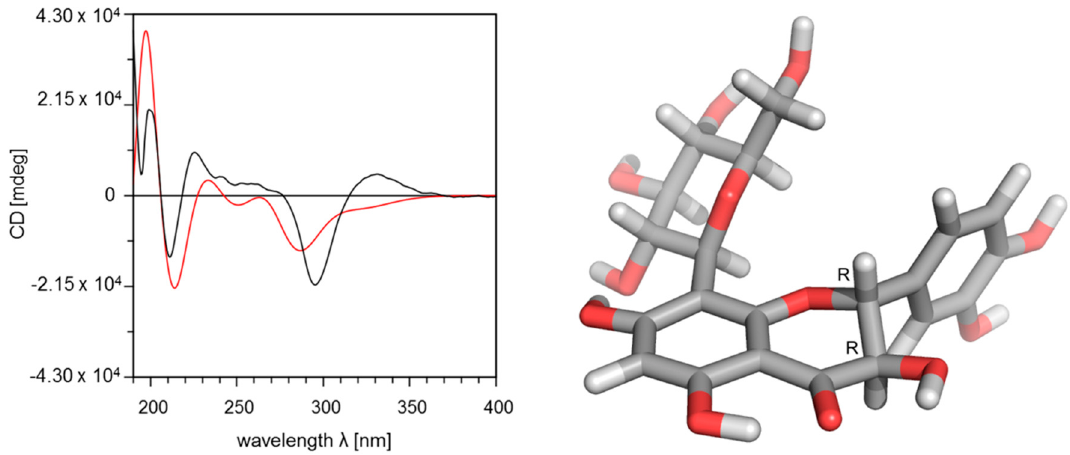
Figure 4. Left: comparison of experimental CD spectrum (black line) with Boltzmann weighted calculated CD spectrum for the (2 R ,3 R )-enantiomer of compound 3 with a similarity factor S = 0.7099 for sigma = 0.3 eV and 18 nm shift. Right: calculated most stable conformation of the (2 R ,3 R )-enantiomer. Table 3. Results of DFT calculations for the (2 R ,3 R) enantiomer of compound 3. Conformation